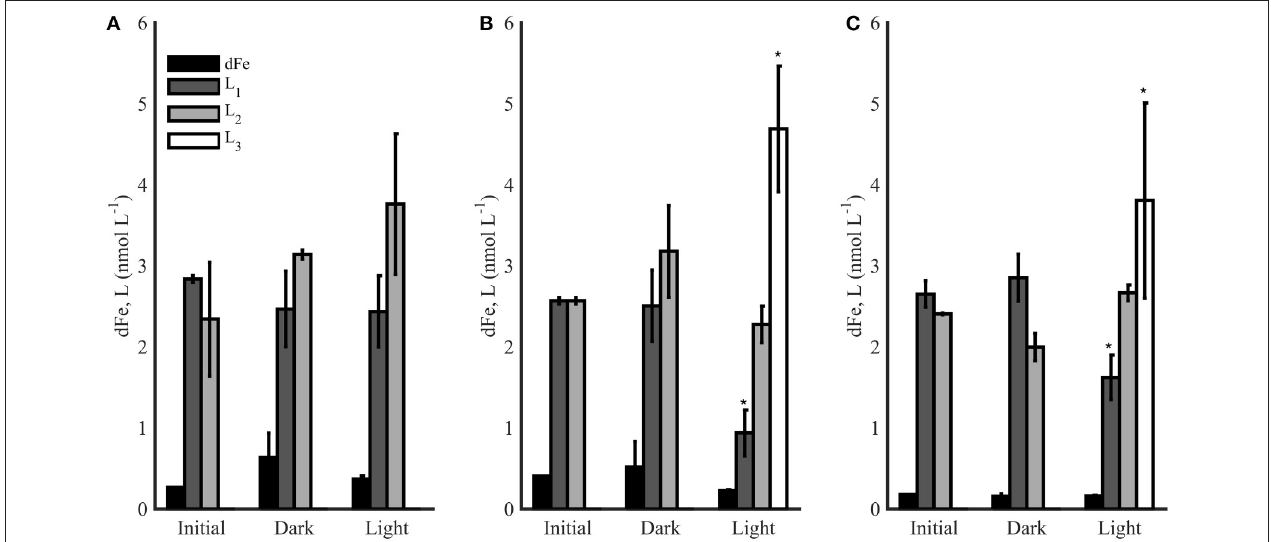
FIGURE 7 | The dFe (black bars) and ligand concentrations (L 1 -L 3 ) for photochemical experiments 1 (A), 2 (B), and 3 (C) in the initial and final conditions after 12h (Dark and Light). Error bars represent the standard deviation between replicate bottles in dark (A, B) and light (A, B) bottles, and * represents a significance difference in ligand concentrations from initial conditions ( t- test, p < 0.05